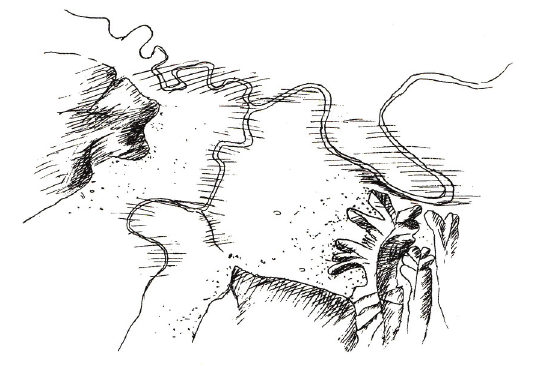
Fig. 2. Le Corbusier, Aircraft, (1935). Figure 56: “ A Revolution in the suitable moment. The truth expels ugliness. A new